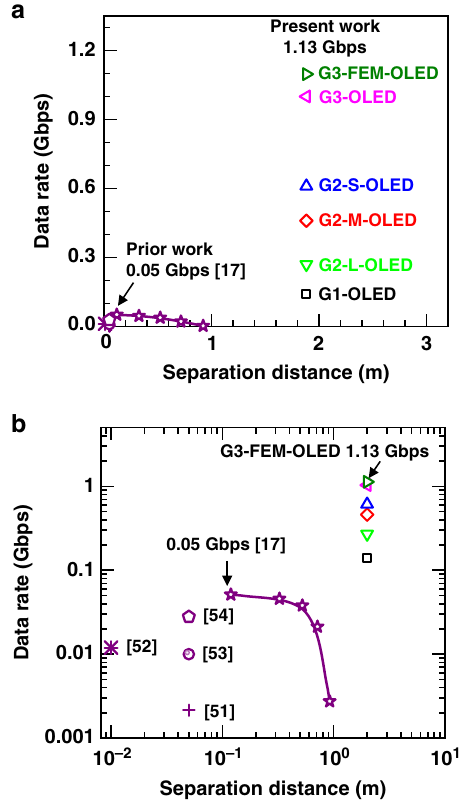
Fig. 4 Comparison of reported OLED data link speeds. Data rate of our OLEDs compared to literature devices as a function of separation distance between OLED and receiver in a wireless data link: a on a linear scale and b on a logarithmic